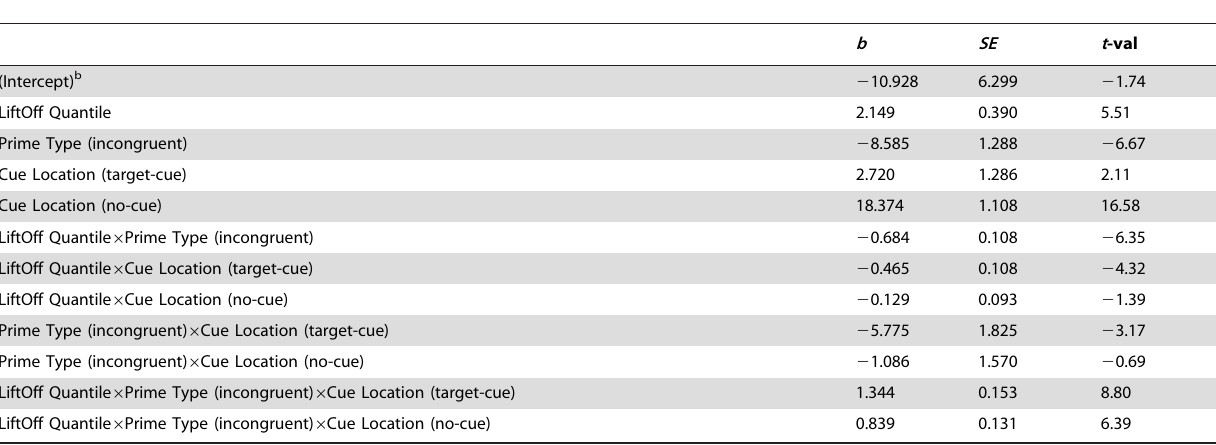
Table 1. Fixed effects for Expt 1A estimated with LMM a .